Question: What type of chart is this?
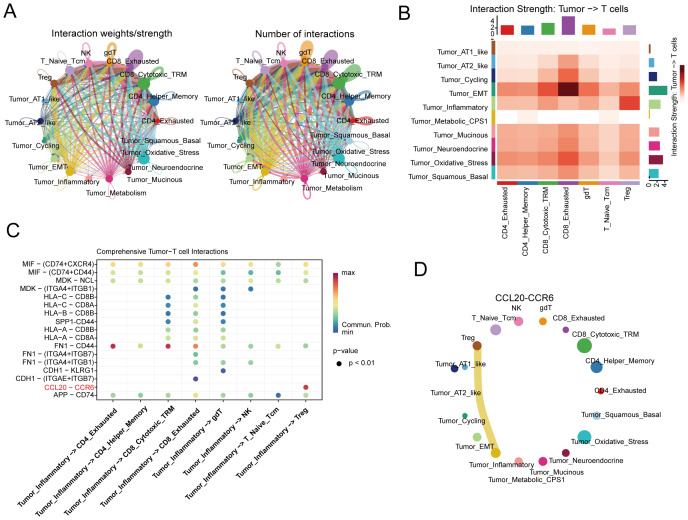
Answer: heatmap